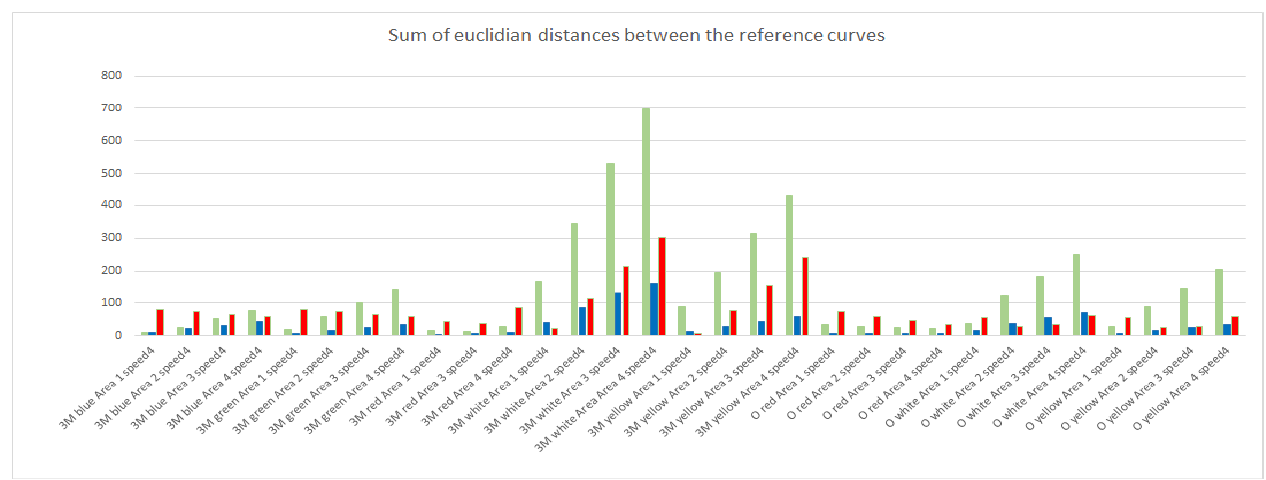
Figure 6. Sum of Euclidian distances between the scenario “3M red Area 2 speed 4” and all the other scenarios for the same speed level.